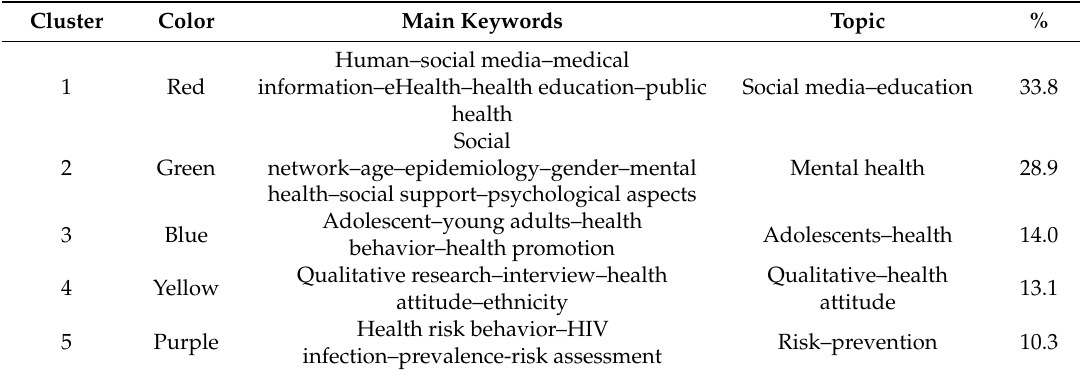
Table 9. Keywords most utilized by the six top communities identified in the topic of social networks related to the health of young people. Cluster